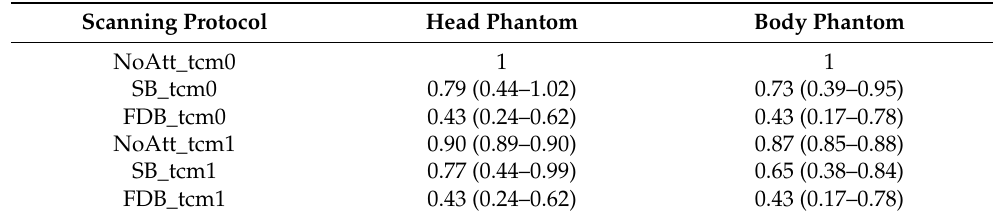
Table 4. Relative dose deposited in the head and body phantoms using different scanning protocols.